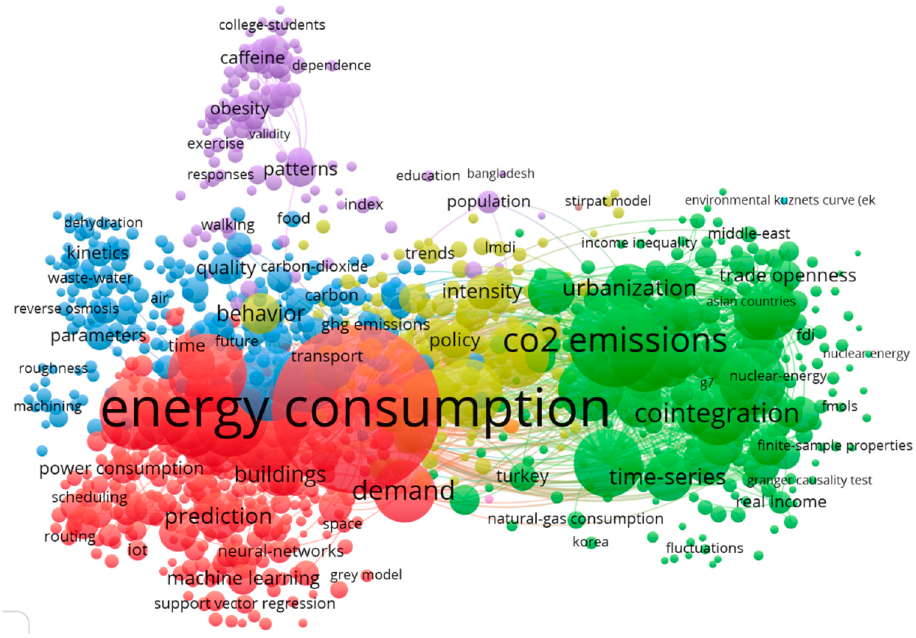
Figure 5. The network map of the bibliometric analysis concerning renewable energy consump ‐ tion.